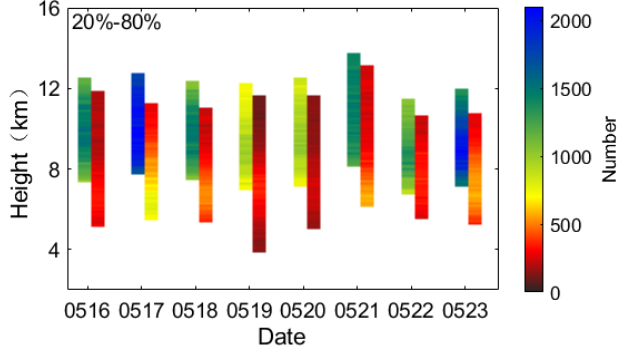
Figure 7. Summary of electrical structure in eight days. For each day, the height distributions of positive IC events located on the left are mainly colored in green and blue, while the negative ones located on the right are mainly colored in yellow and dark red.